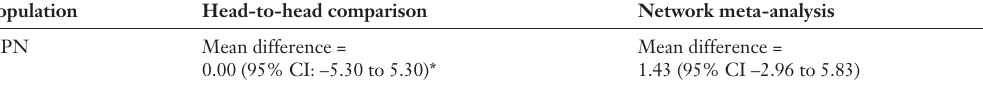
Comparison of results from head- to-head comparison and network meta-analysis. Comparative effect on change in pain score (from baseline to end point) of 5% lidocaine medicated plaster and pregaba- lin (600